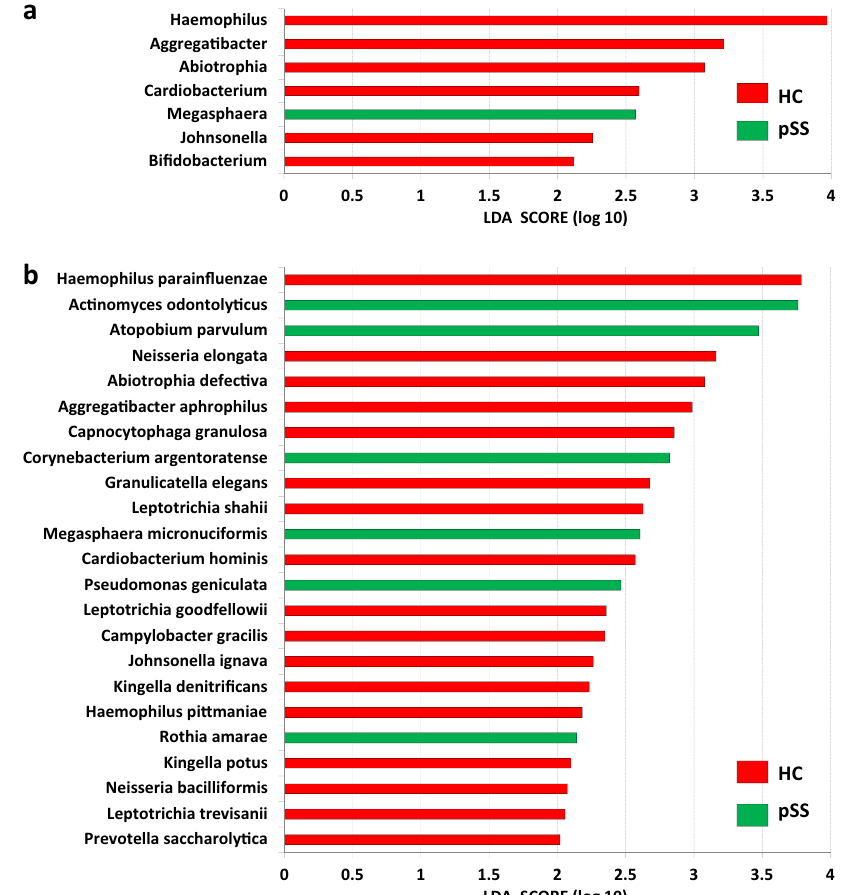
Fig. 3 LDA scores of differentially abundant genera and species of salivary microbiota in primary Sjögren ’ s syndrome patients and healthy controls by linear discriminant analysis effect size (LEfSe). Green bars represent genera and species enriched in pSS patients ( “ pSS ” ), while red bars denote those enriched in healthy controls ( “ HC ” ). The genera and species are ordered by the LDA score, a measurement of effect size, at a the genus level and b the species level. Haemophilus and H. parain fl uenzae had the highest LDA scores at the genus and species levels, respectively. Only genera and species of the fi nal set (refer to Supplementary Table 1) are